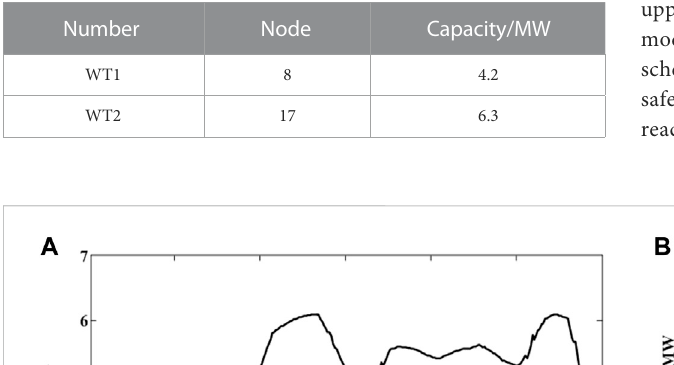
TABLE 3 The parameters of the dispersed wind farm.